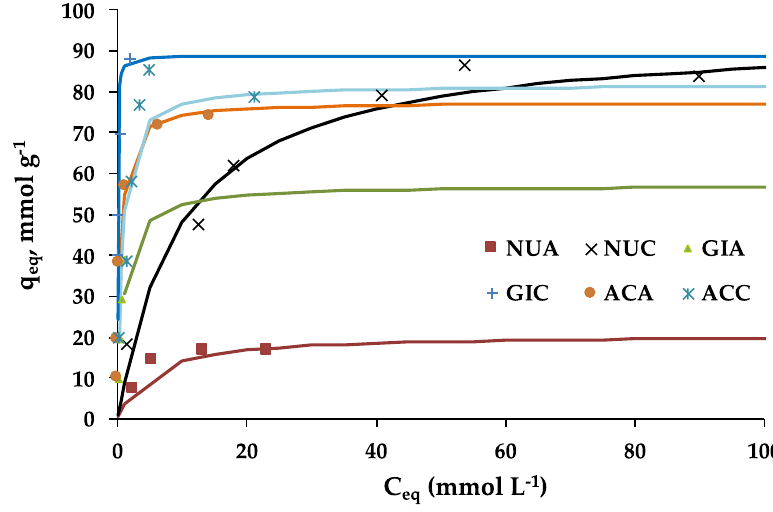
Figure 3. Nicotinic acid adsorption isotherms.